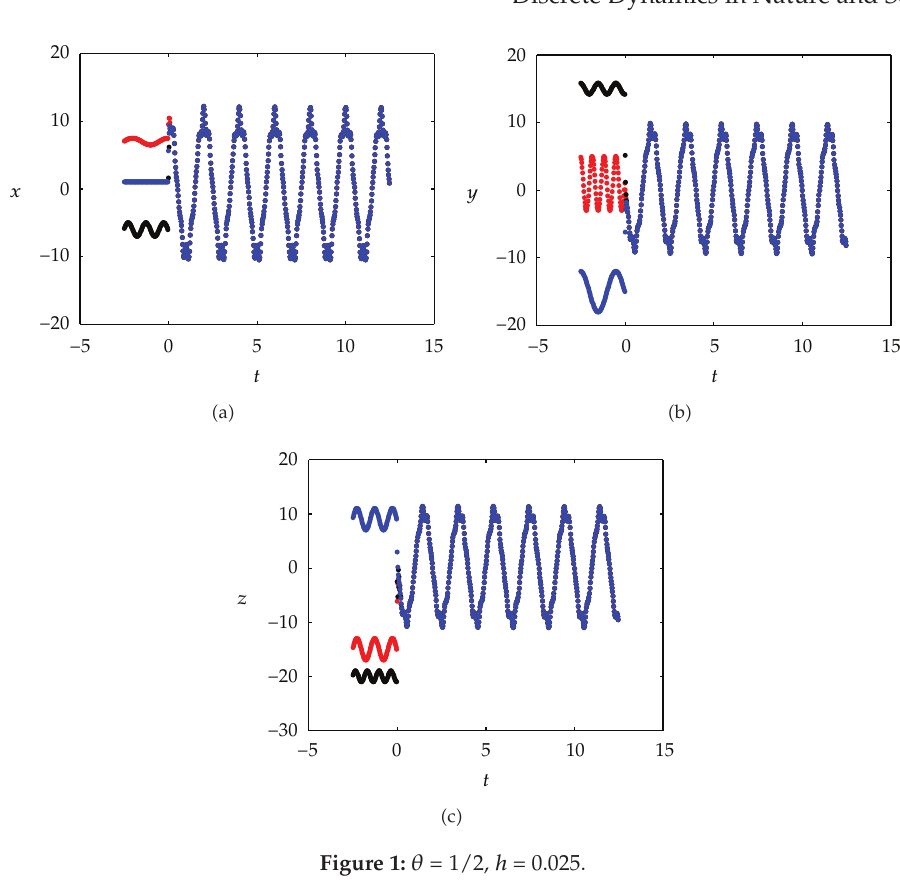
Figure 1: θ (cid:5) 1 / 2, h (cid:5)